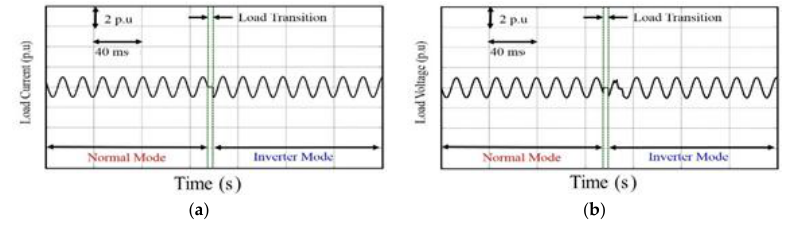
Figure 10. ( a ) Load current; and ( b ) load voltage of the proposed offline UPS system.